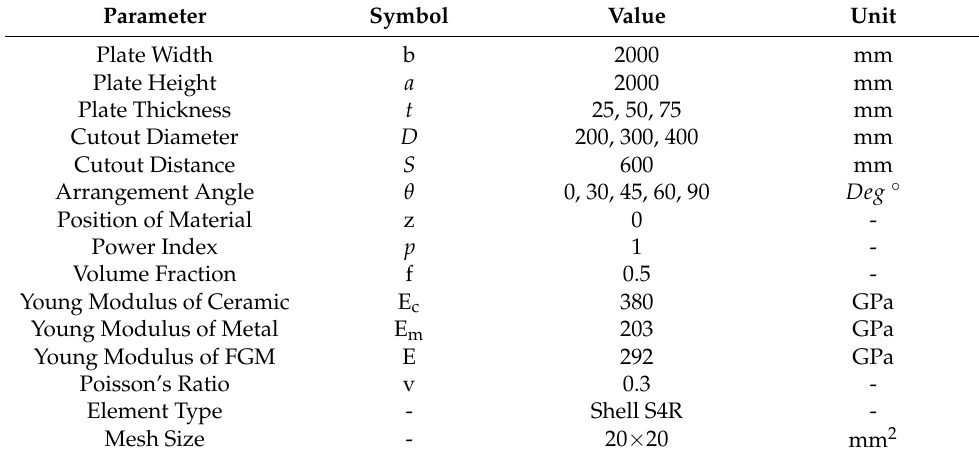
Table 1. Input parameters for the numerical simulation.